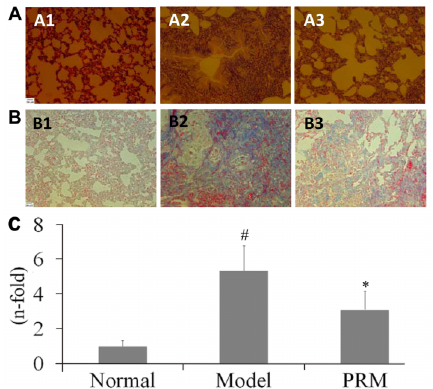
Figure 5. Effects of pulmonary rehabilitation mixture (PRM) on histopathological change and collagen content in bleomycin (BLM)-treated animals. Representative light microscopic appear- ance of HE staining and Masson staining in lung tissue for the normal ( A1 , B1 ), model ( A2 , B2 ), and 3 g/kg PRM ( A3 , B3 ). C , Effects of PRM on collagen content in BLM-treated animals. Data are reported as means±SD. # P , 0.01 vs the normal group; *P , 0.01 vs the model group (one-way ANOVA followed by Dunnett’s test).